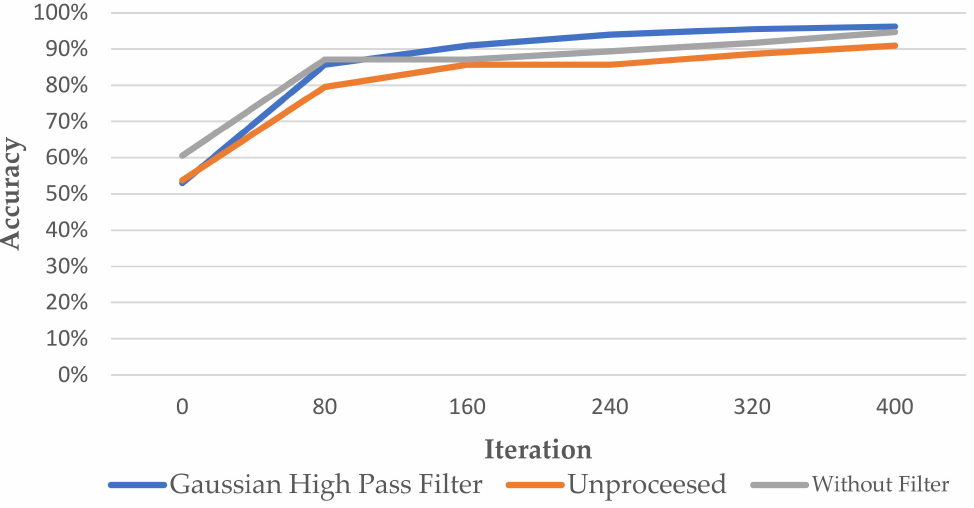
Figure 12. Comparison of the accuracy of AlexNet’s training process for the unprocessed image, applied Gaussian high pass filter and without